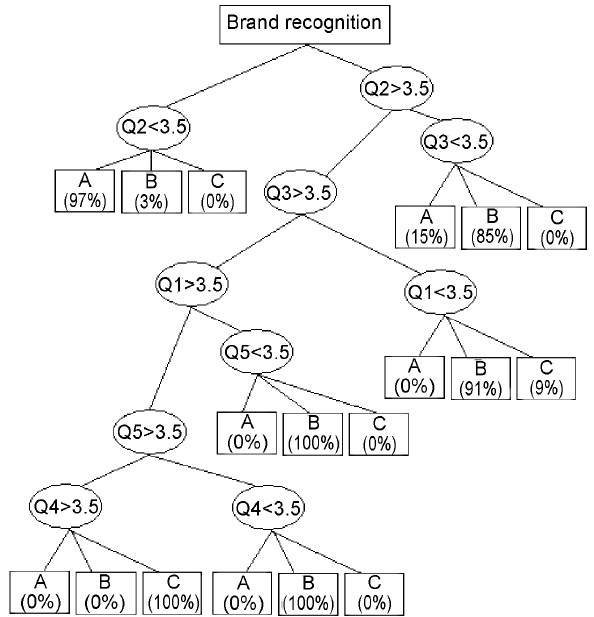
Fig. 1. A Decision Tree with “brand recognition” as objective